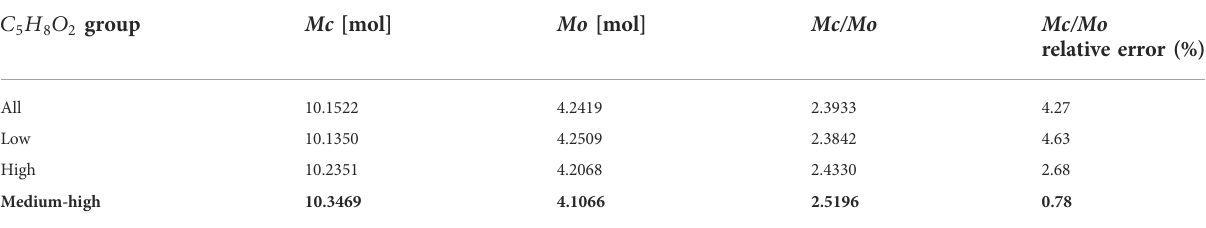
TABLE 5 Numeric solution of PMMA.